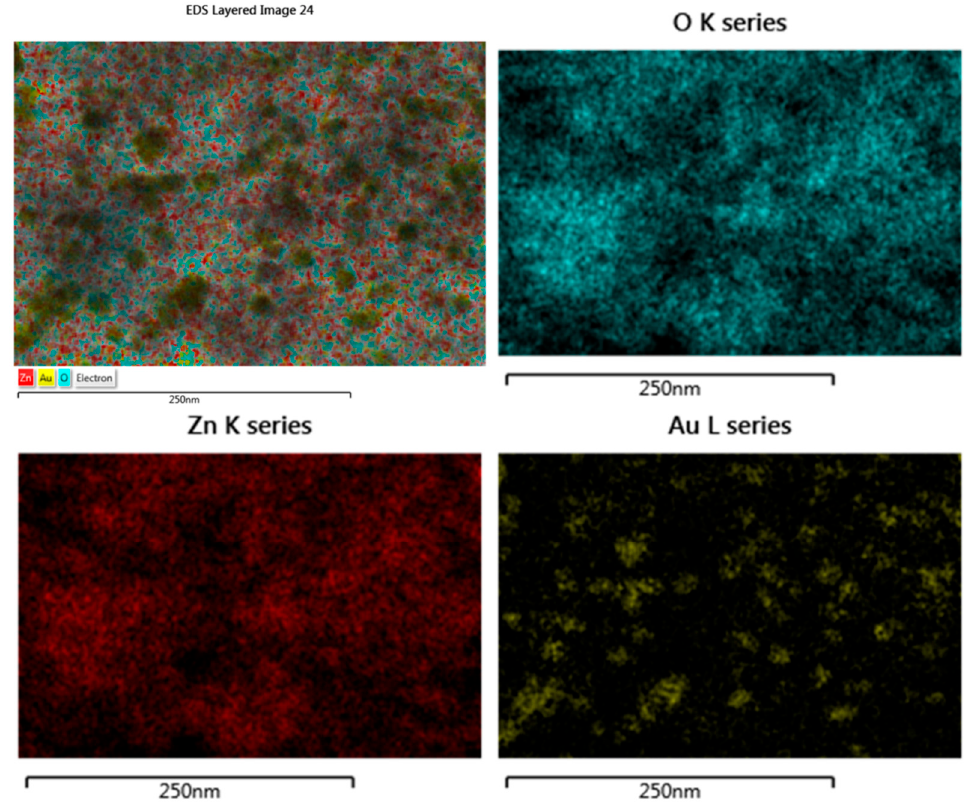
Figure 4. The EDS mapping of the ZnO-Au2 nanocomposites.